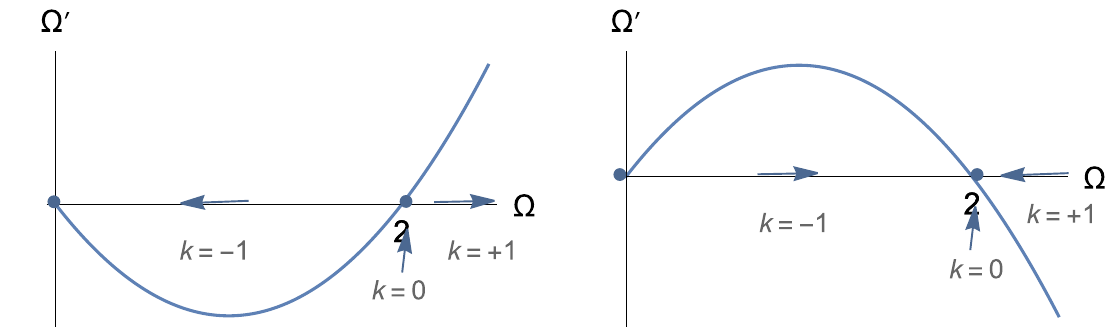
Fig. 4 The 1-dimensional phase space ( (cid:4) -line) in the linear fluid case. The Figure on the left (right) shows the case γ > − 1 / 2 ( γ < − 1 / 2). The arrows correspond to evolution in positive τ Fig. 5 Phase portrait of the system (2.27)–(2.28) for γ < − 1 / 2 and γ > − 1 / 2. The stable node at ( 0 , 2 ) (left), exchanges stability with the saddle ( 0 , 0 ) (right) as the γ values change